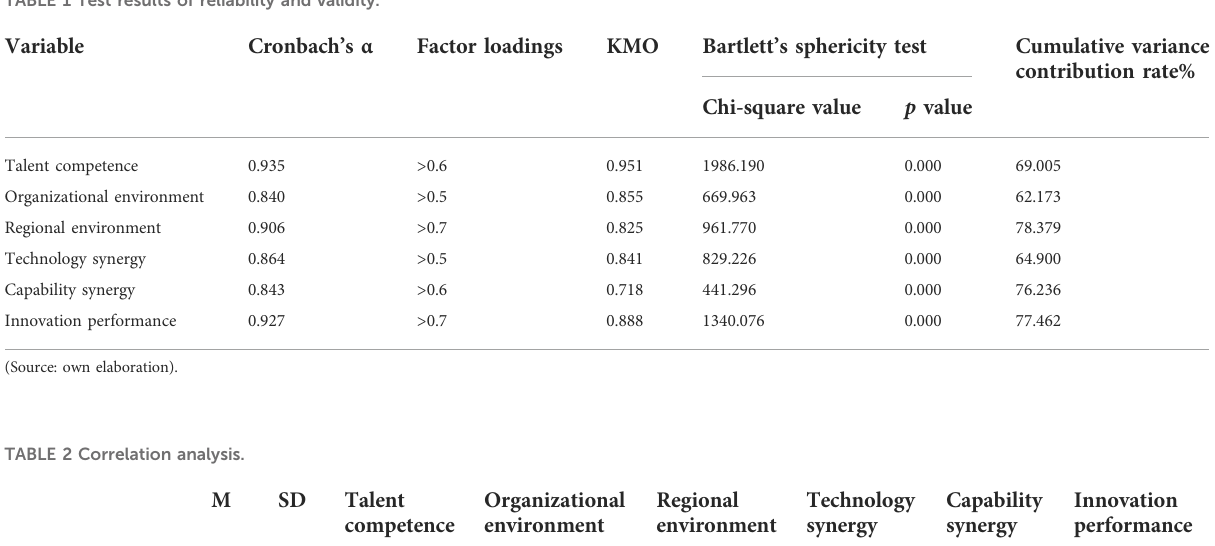
TABLE 1 Test results of reliability and validity. Variable